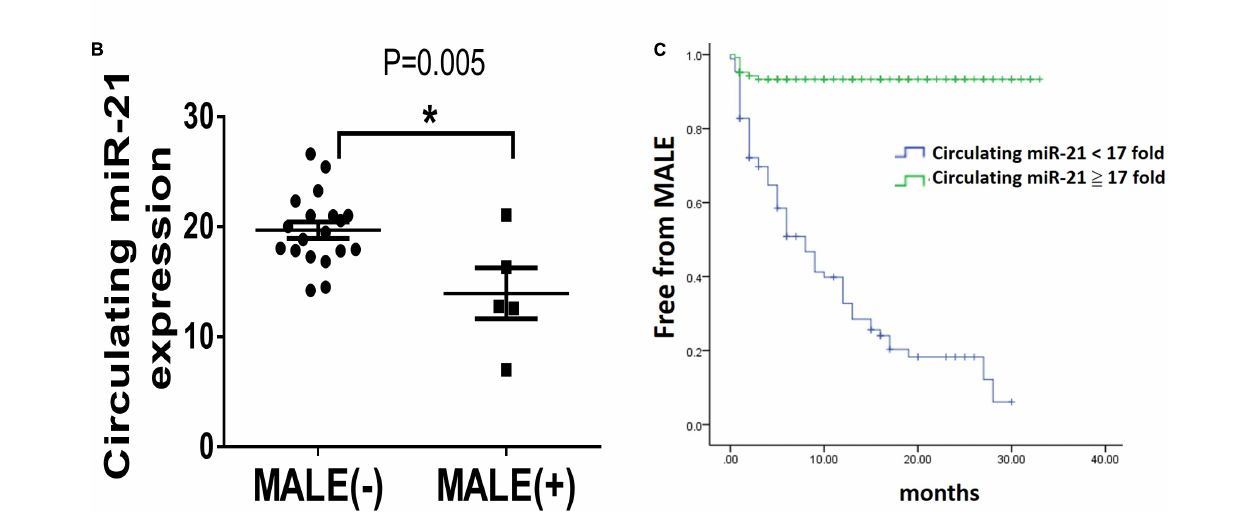
FIGURE 6 | Lower circulating microRNA-21 (miR-21) expression in patients with peripheral artery disease (PAD) is associated with more major adverse limb events (MALEs). (A) The design of a clinical study focusing on patients with PAD. (B) The expression of circulating miR-21 in patients with or without the development of MALEs. (C) A Kaplan–Meier plot of MALEs among patients with high or low expression of circulating miR-21 ( N = 20, * P < 0.05). *The cutoff value of miR-21 was defined as a 17-fold change compared with the control